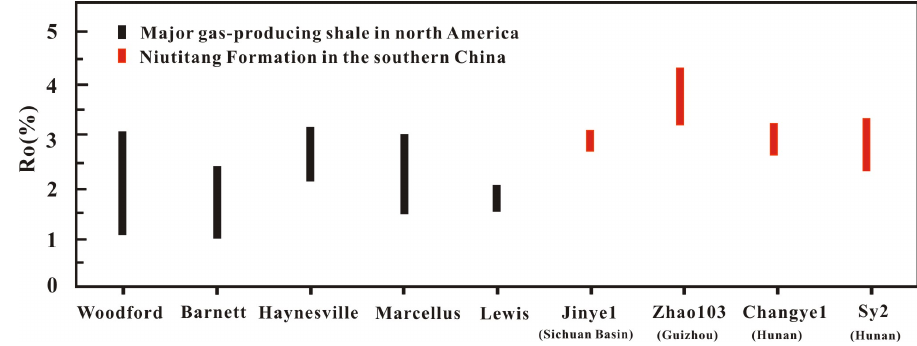
Figure 2. Thermal maturity of shale gas plays from North America and southern China.